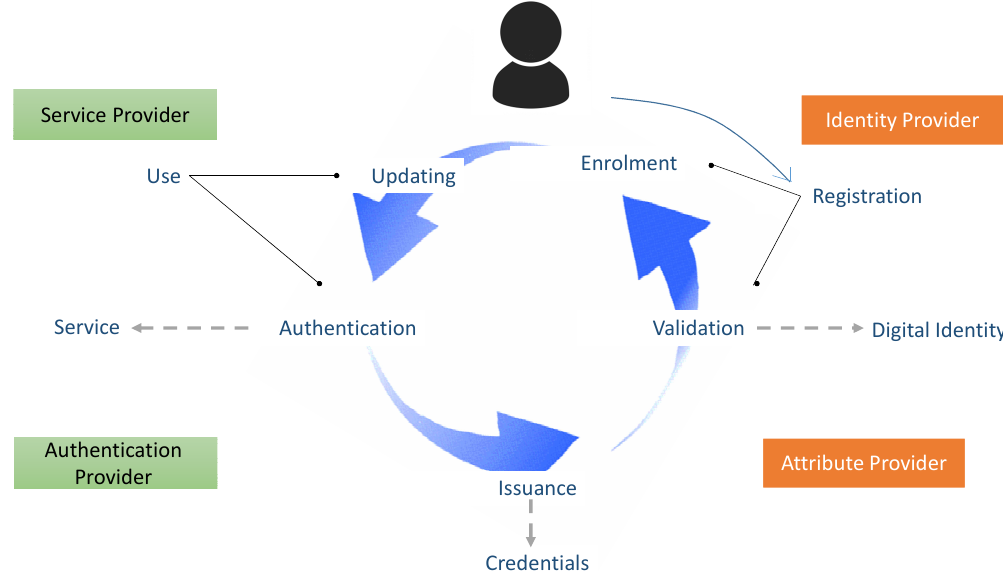
Figure 1. Digital identity life cycle and key